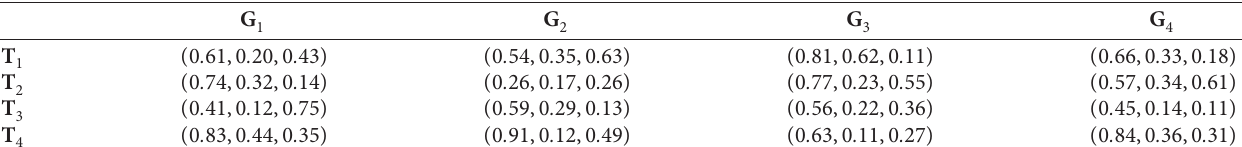
Table 2: Normalized decision